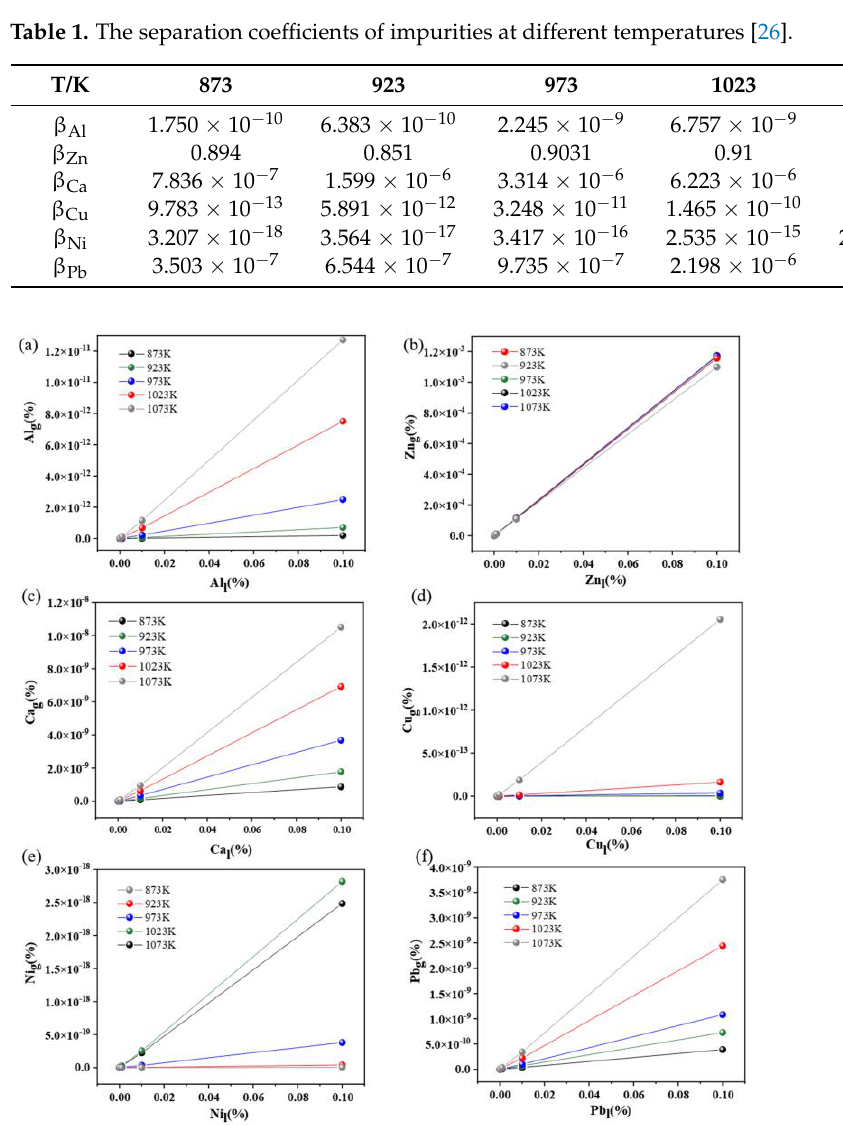
Figure 2. The gas-liquid equilibrium diagrams of impurities (( a ) Al, ( b ) Zn, ( c ) Ca, ( d ) Cu, ( e ) Ni, ( f ) Pb).